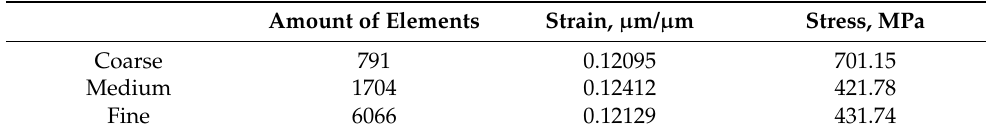
Table 2. Study results of grid-independent